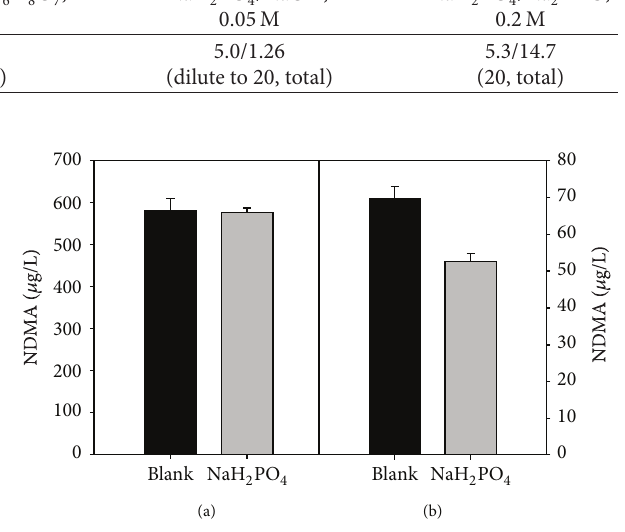
F 5: (a) Amounts of NDMA formed aer 2h from the reaction (40mM) with DMA (0.4mM). (b) of a large excess of NaNO AmountsofNDMAformedfromthereactionbetweenalargeexcess 2 (0.4mM).ereactionsolutionswere ofDMA(40mM)andNaNO C with the concentration buffered at pH 6.4 citrate buffer at 90 2 PO being 1mM. e vertical bars represent the standard of NaH ∘ deviation ( 2 4 𝑛𝑛 𝑛 3